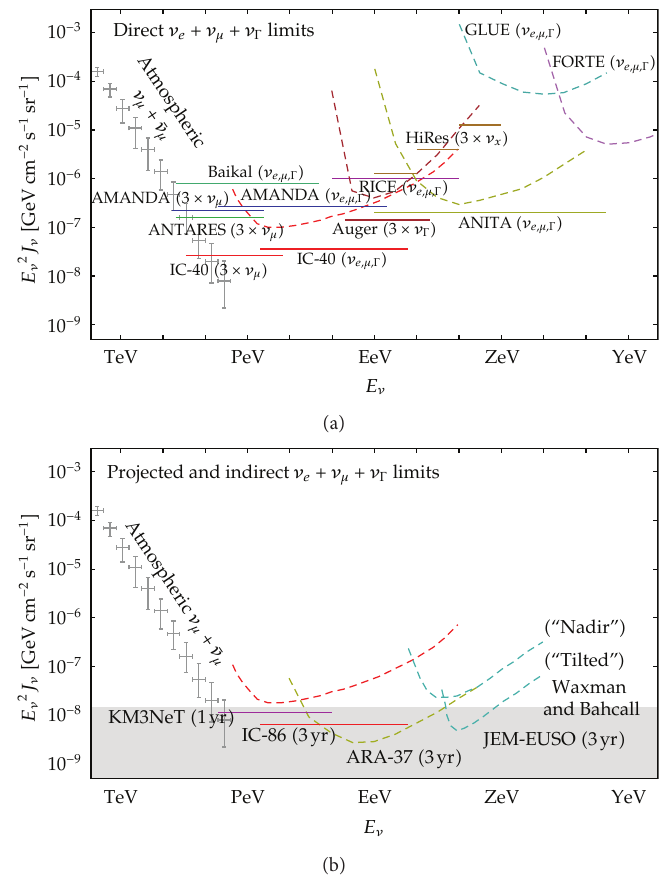
Figure 13: Limits on a diffuse neutrino flux from existing and, below, future experiments [16, 90–99]. Figure courtesy of M. Ahlers [100].